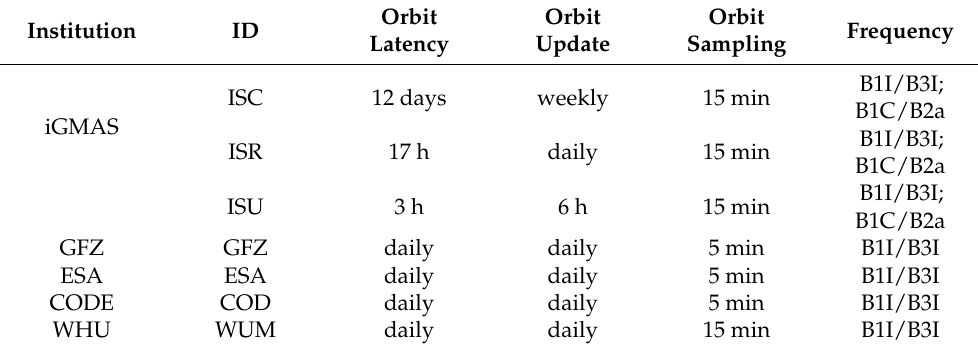
Table 1. Overview of the orbit products from iGMAS and four MGEX ACs.